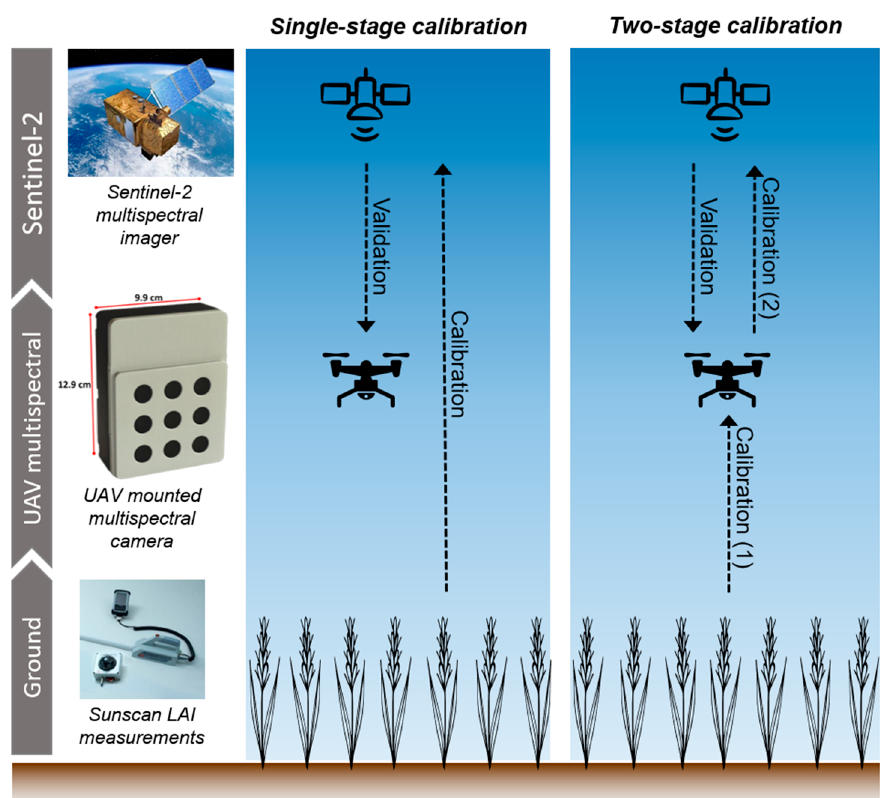
Figure 3. Overview of approaches for calibrating GPR models used for retrieving LAI from Sentinel-2 data. Including: ( a ) single-stage calibration based on ground measurements and ( b ) indirect calibration involving, first, upscaling ground measurement using high-resolution UAV data and, second, calibrating the Sentinel-2 retrieval model based on UAV LAI data. Validation of both approaches performed using UAV data averages per Sentinel-2 pixel.